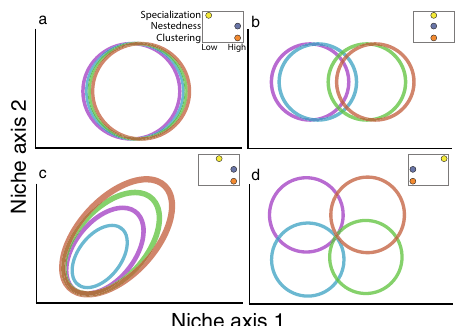
Fig. 1 Example con fi gurations of niches (circles/ellipses) of a population of four individuals along two resource axes. Colors indicate different individuals. Niches might be all similar and overlapping ( a ), clustered into a limited number of groups ( b ), nested according to a generalist/specialist gradient ( c ), or are different and occupying separate parts of environment space ( d ). Each of the four scenarios implies different patterns of specialization, nestedness, and clustering — the three metrics used in this study to delineate realized con fi gurations. See text for further details and